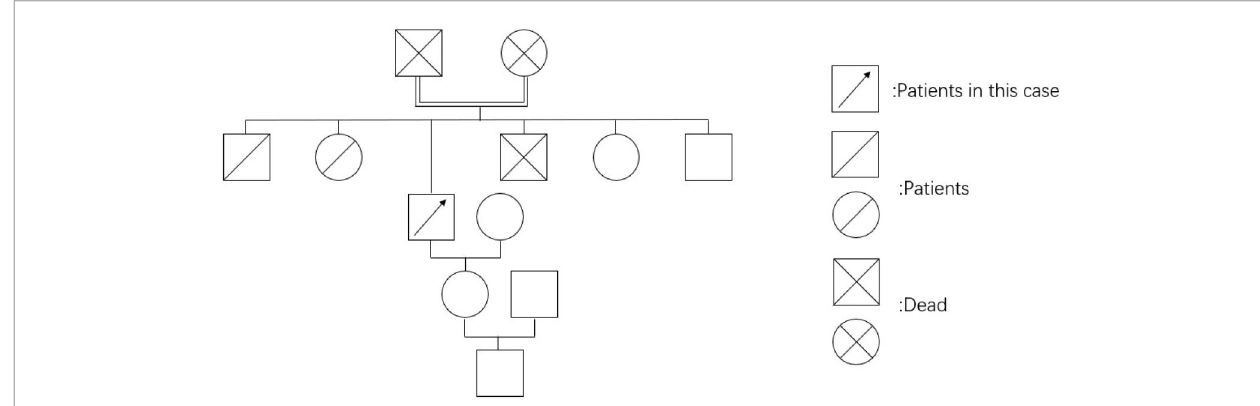
FIGURE 1 | The pedigree map of the patient ’ s